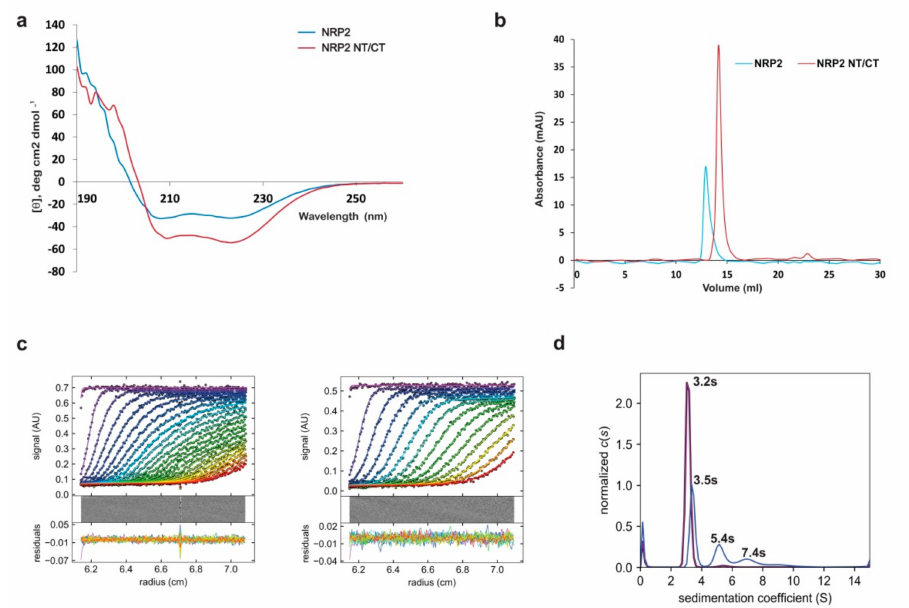
Figure 3. Secondary structure and oligomerization status determination of AtNRP2. ( a ) The near-UV Circular dichroism (CD) spectroscopy profile of full-length AtNRP2 and AtNRP2 NT / CT, showing them to be predominantly α -helical in composition. ( b ) Analytical gel-filtration chromatogram of full-length AtNRP2 and AtNRP2 NT / CT. The elution volumes obtained were nearly 12.9 and 14.0 mL, respectively, which correspond to the sizes bigger than those of the dimers. ( c ) Sedimentation velocity analytical ultra-centrifugation of AtNRP2 (left panel) and AtNRP2 NT / CT (middle panel). ( d ) The plot shows the fitting on c(s) analysis and the distribution of sedimentation coe ffi cients for both the proteins respectively (right panel). Peaks in blue represent full-length AtNRP2 and peaks in purple represent AtNRP2 NT / CT. The higher ‘s’ value corresponds to bigger